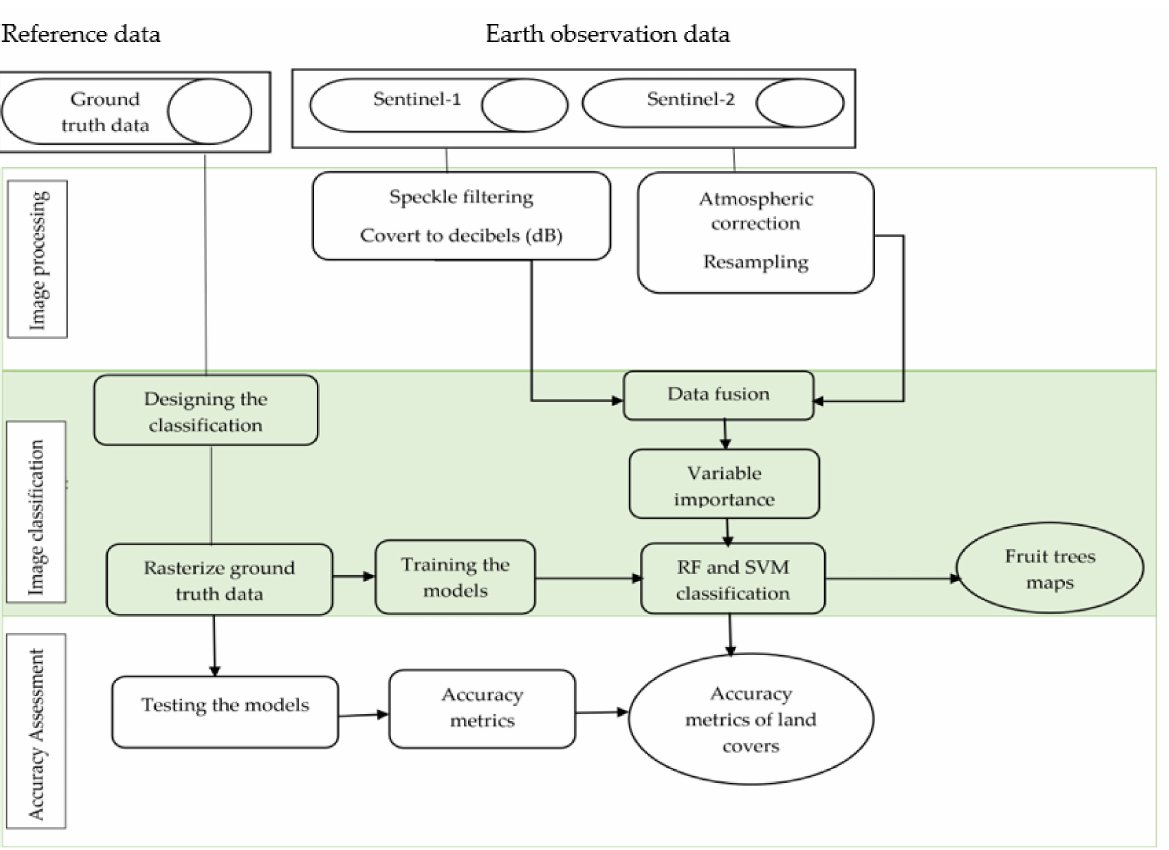
Figure 1. Flowchart of the methodology implemented for mapping fruit trees and co-existing land-use types in Levubu, Limpopo, South